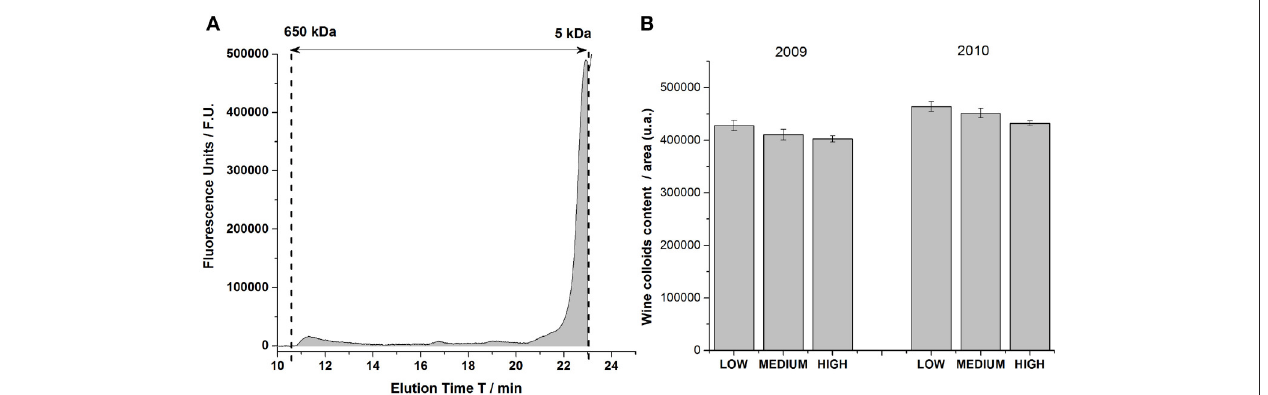
FIGURE 1 | (A) Chromatogram of a chardonnay wine in the calibrated domain comprised between 5 kDa and 650 kDa, obtained by size exclusion chromatography. The gray-filled area under the chromatogram represented the total area of wine colloids contained in this wine, and detected by fluorescence. (B) Histogram representing the overall colloids content for vintage 2009 and 2010 for the three levels of must turbidity (Low, Medium and High). Each bar of the histogram gathered the medium value of colloids content from 4 bottles (2 types of closure × 2 replicates), with its error bar.